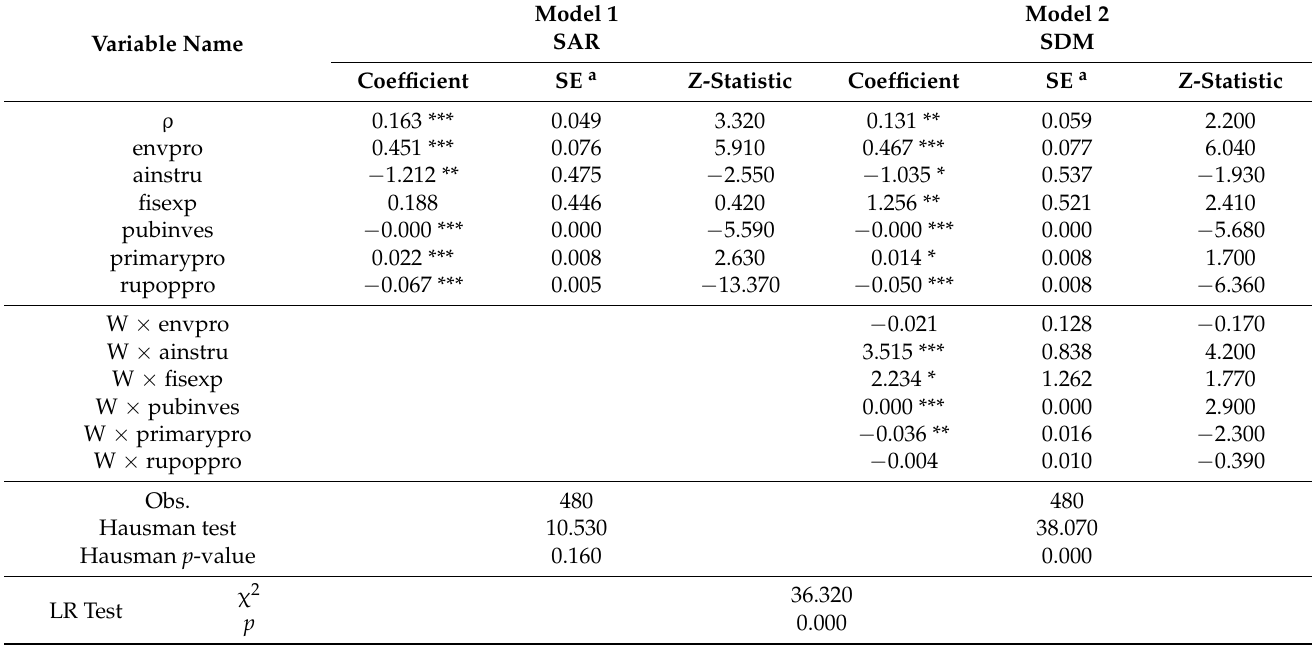
Table 2. Strategic interaction estimation of local government’s carbon peak